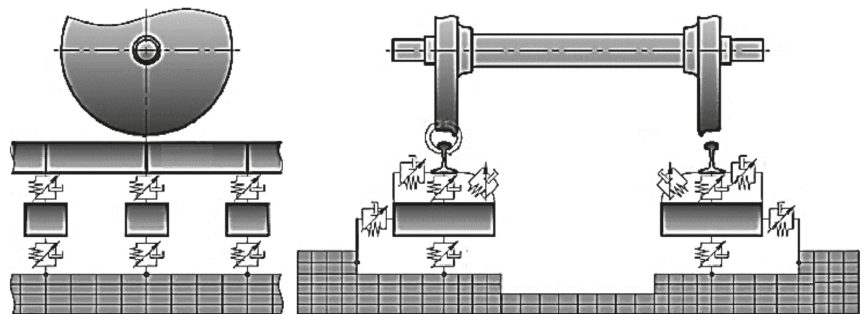
Figure 7: Track structure model